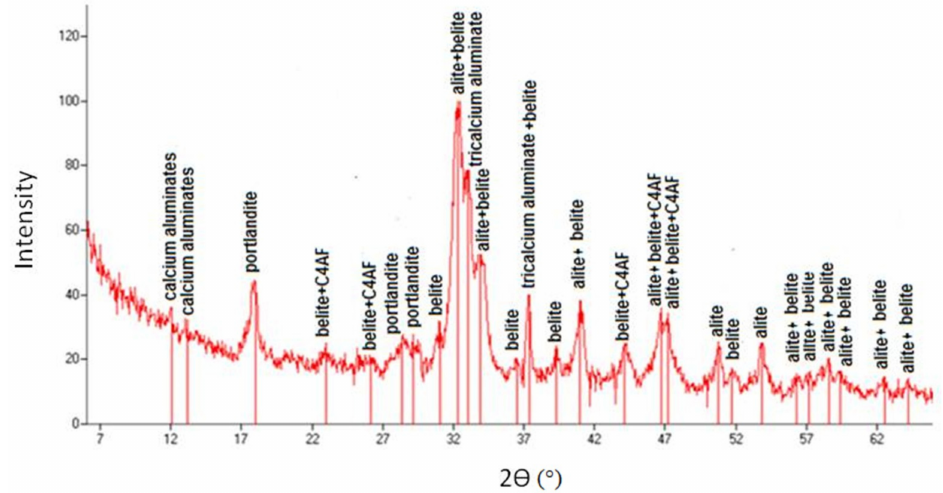
Figure 25. XRD patterns of cement paste from recycled aggregates after thermo-mechanical treatment (calcinating in 650 ◦ C by 60